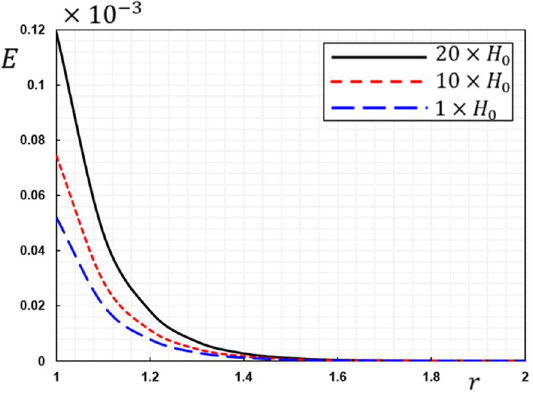
Figure 7. The induced electric field, E , versus the axial magnetic field, H 0